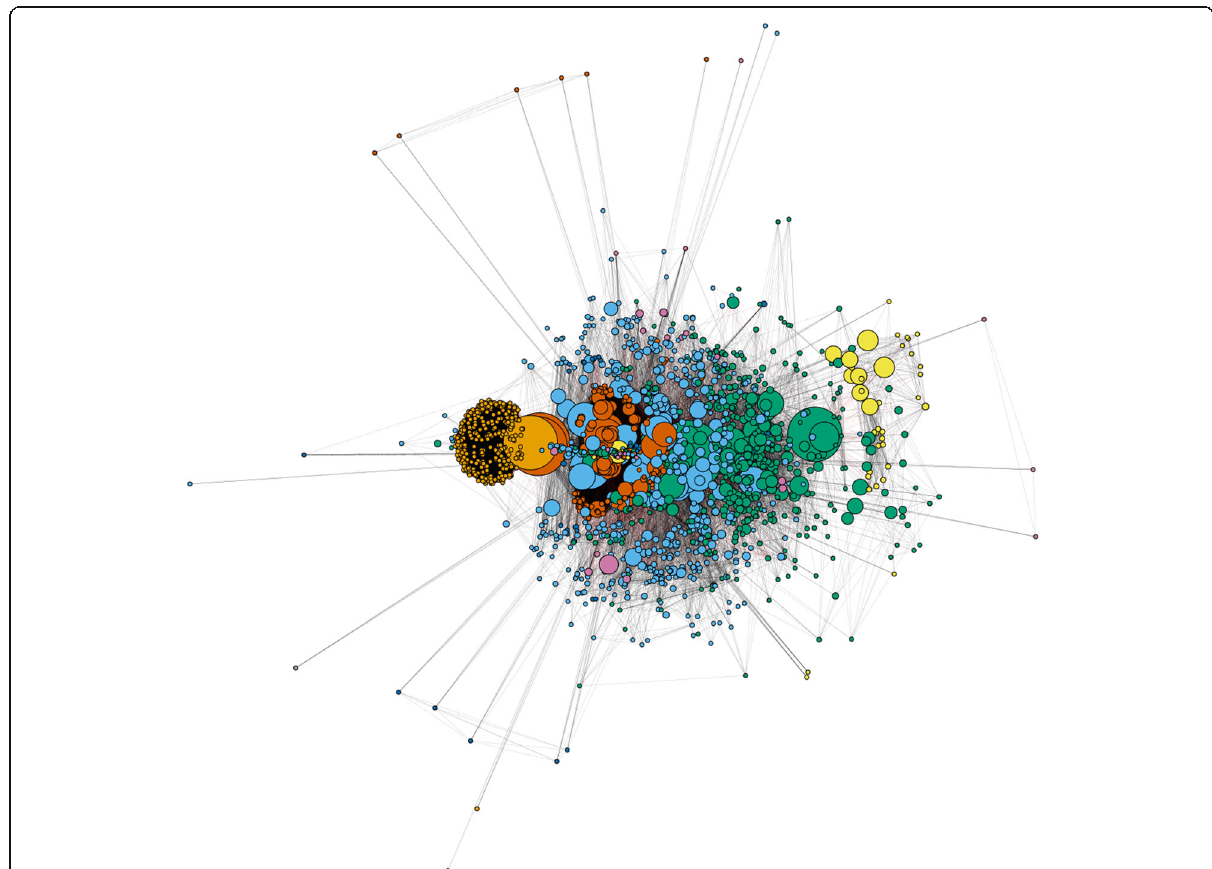
Fig. 3 Malaria Co-authorship network – Main component. Authors (vertices) of the same color belong to the same research community or cluster